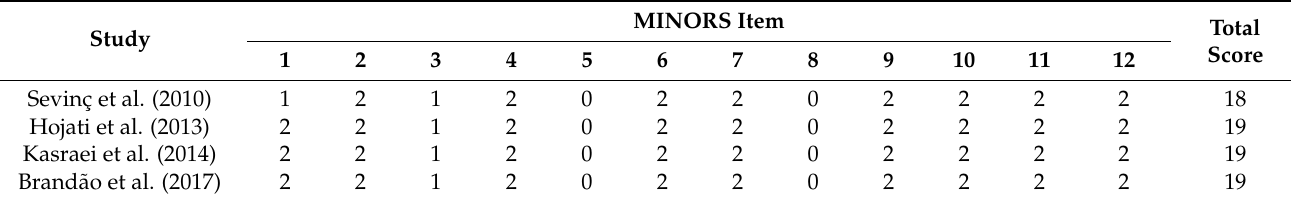
Figure 2. Summary of modified Methodological Index for Non-Randomized Studies (MINORS) analysis scores. Table 4. Modified MINORS analysis scores for each item.